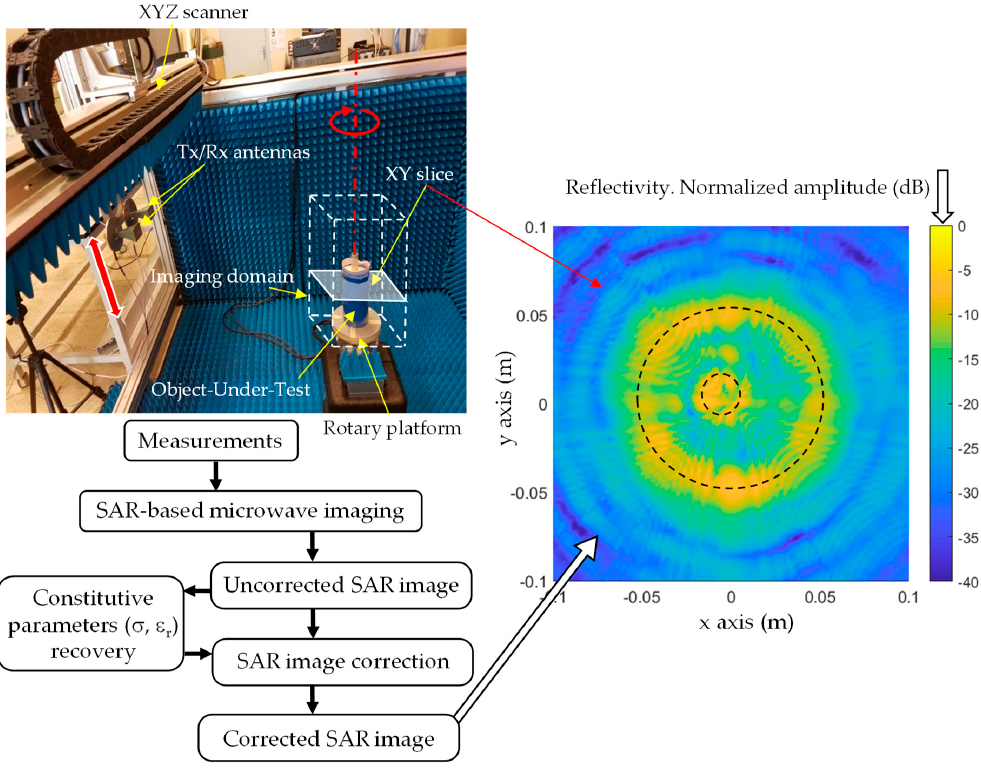
Figure 3. Picture of the measurement setup and flowchart of the Synthetic Aperture Radar (SAR)-based technique for microwave imaging and constitutive parameters characterization.